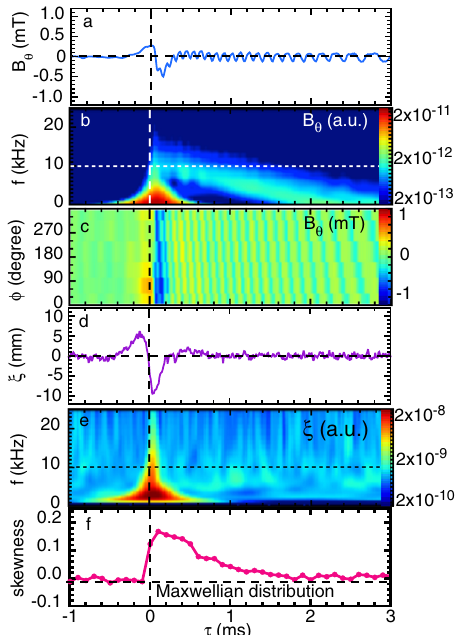
Fig. 5 Characteristics of transit-time damping. Time evolution of a magnetic fi eld perturbation, b frequency spectrum power of magnetic fi eld perturbation, c contour of magnetic fi eld perturbation, d plasma displacement at r eff / a 99 = 0.83 evaluated from perturbation of electron temperature, e frequency spectrum power of plasma displacement, and f skewness of ion velocity distribution function at r eff / a 99 = 0.79 with conditional averaging with respect to the collapse time of energetic ions, as indicated by the sharp increase in radio frequency (RF) intensity, plotted in Fig. 1c. (#165933, #165935, #165942, #165944, #165946, #165958, #165964, #165965, #165968, #165979, #165985, #166002,